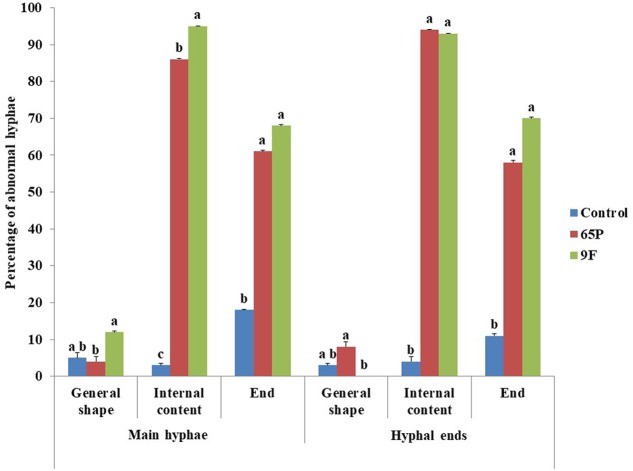
Effect of A. terreus on the hyphal morphology of P. aphanidermatum. Columns and bars represent percentage ± CV of SD. Values with the same letters are not significantly different from each other (Pearson Chi-Square: asymptotic significance, 2-sided; > 0.05).